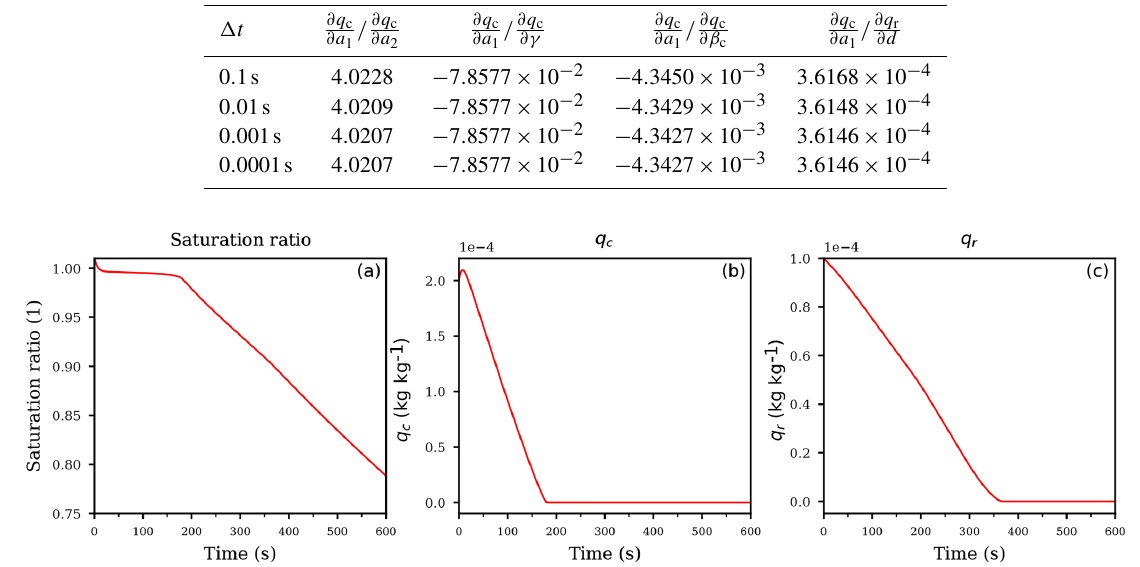
Figure 5. Temporal evolution of the saturation ratio S (a) , the cloud droplet mixing ratio q c (b) , and the rain drop mixing ratio q r (c) for the descending air parcel with evaporating